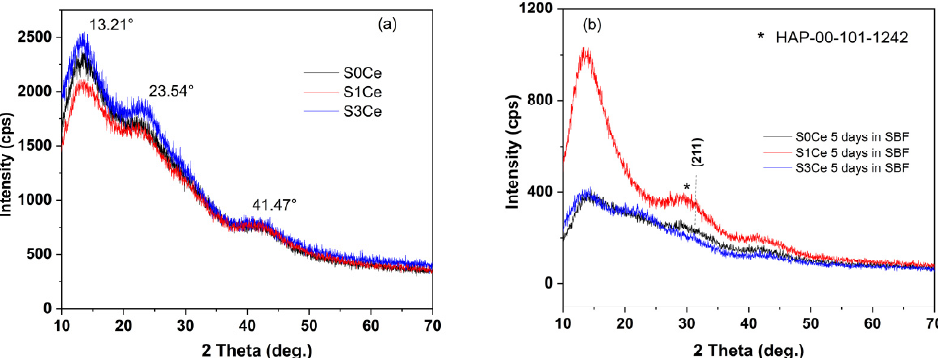
Figure 7. XRD patterns of S0Ce-S3Ce composite scaffolds ( a ) before immersion in SBF and ( b ) after immersion in SBF for five days.